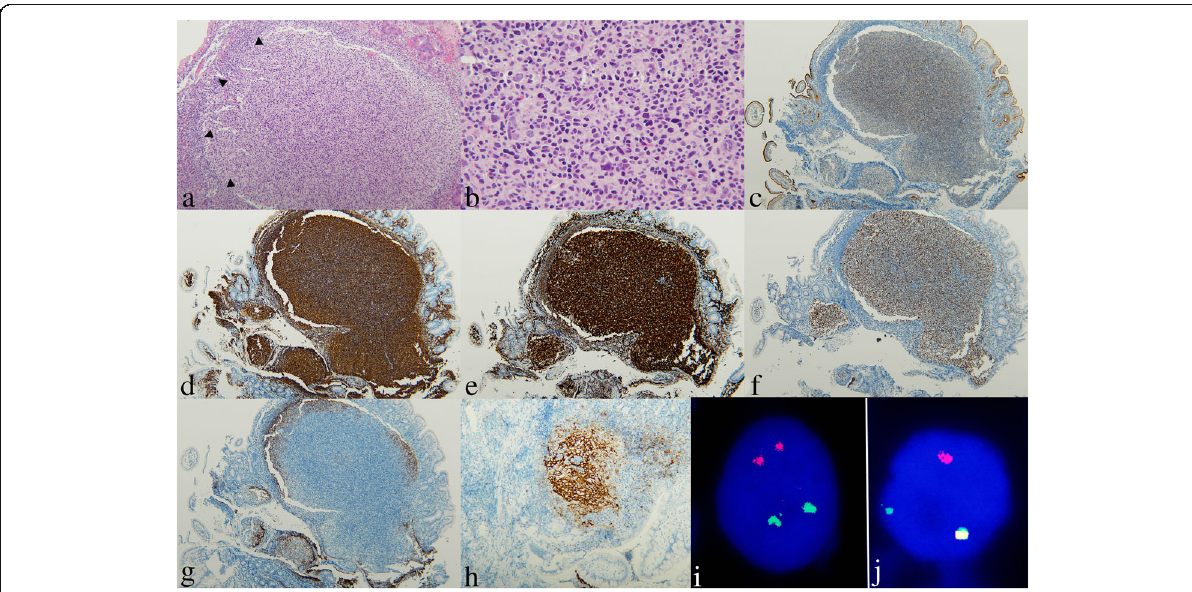
Fig. 2 A representative case of a low-grade primary intestinal follicular lymphoma (Case No. 4, except Panel h, i and j). a Low-power view shows a large lymphoid follicle in the lamina propria of duodenal mucosa (H&E stain, × 40). The mantle zone indicated by black arrowheads is attenuated. In this case, the mucosa is intact, without erosion or ulceration. b The follicle is composed mainly of small- to medium-sized centrocytes without tingible body macrophages (× 400). Immunohistochemistry shows that the neoplastic cells express CD10 ( c , × 40), CD20 ( d , × 40), BCL-2 ( e , × 40), and BCL-6 ( f , × 40). The follicular dendritic meshworks of this case show a characteristic duodenal pattern by immunostaining with CD23 ( g , × 40), in contrast to the nodal pattern in Case no. 11 ( h , × 40). FISH assay using Vysis IGH/BCL2 Dual Color, Dual Fusion Translocation Probe ( IGH in SpectrumGreen and BCL2 in SpectrumOrange). i A normal cell showing two orange and two green signals (2O2G), indicating no translocation of either IGH or BCL2 genes. j A neoplastic cell with reciprocal IGH/BCL2 translocation showing one orange, one green (representing the normal homolog) and one fused (orange/green) signal in yellow (1O1G1F; i and j from Case no.